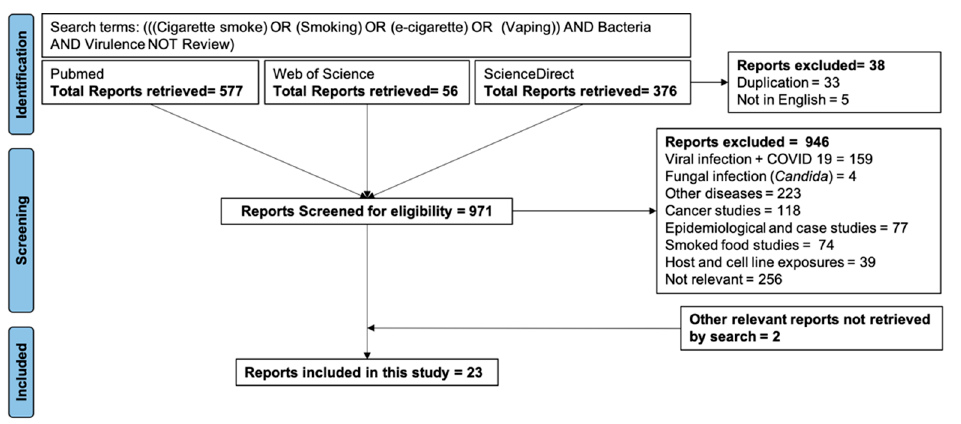
Figure 1. PRISMA criteria for selecting studies for review.